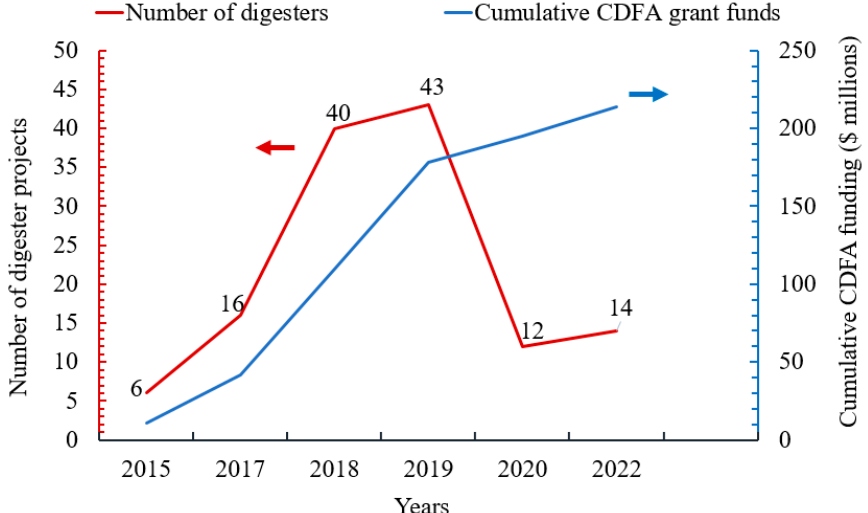
Figure 6. Number of digester projects and total funding for the DDRDP [4].